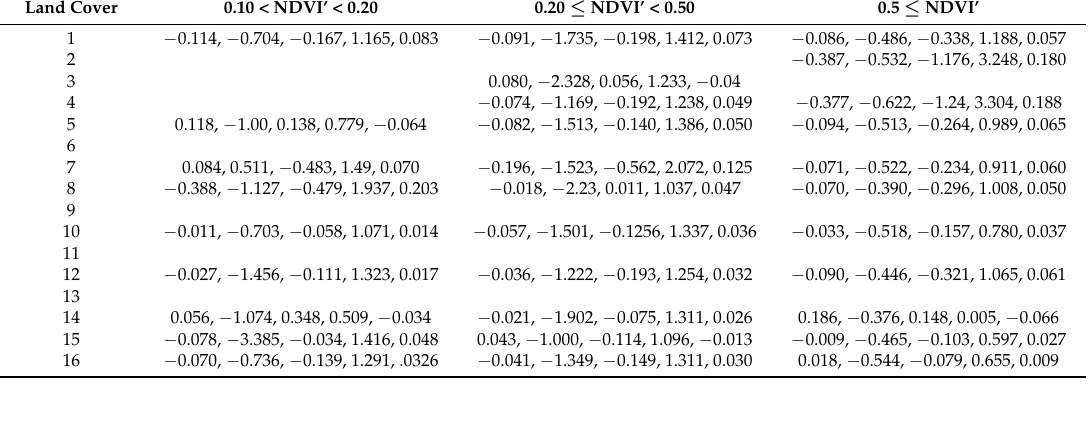
Table 8. Surface Reflectance Coefficients for 0.67 µm for SON.